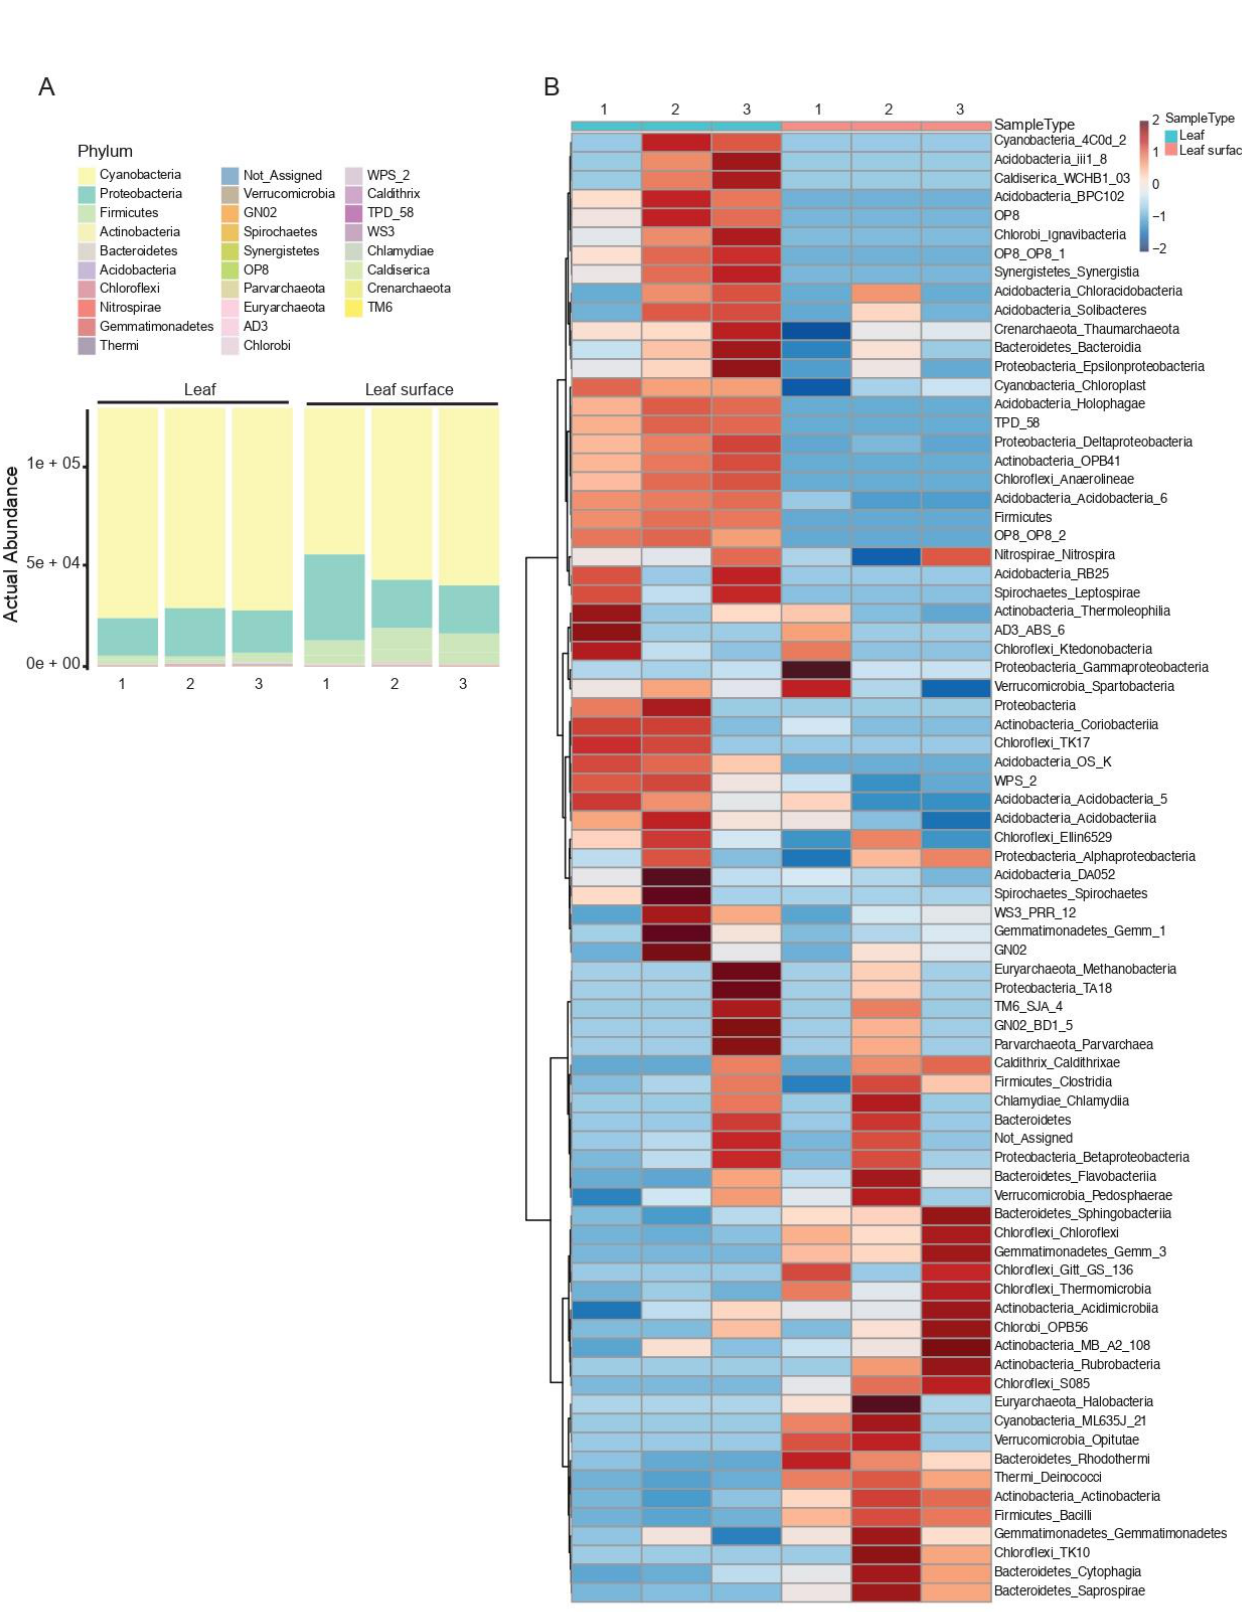
Figure 4. ( A ) Actual abundance at the phylum level of leaf and phyllosphere samples of three individual C. colocynthis plants. ( B ) Heatmap of taxonomic composition at the Class level of leaf and phyllosphere samples between three different C. colocynthis plants. Labels are Phylum_Class, based on Greengenes Taxonomy reference